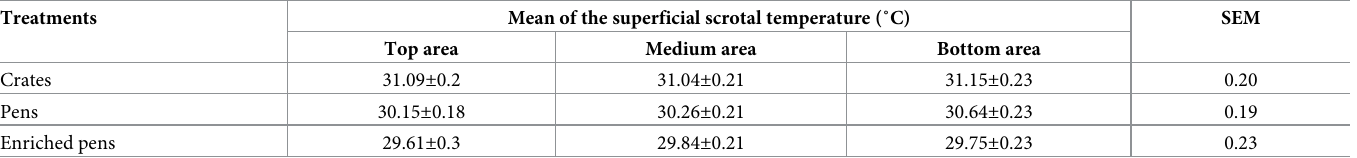
Table 3. Superficial Scrotal Mean Temperature (SSMT) and Standard Error Mean (SEM) of different areas of the scrotum from boars housed in three different con- ditions (Pens n = 9; crates n = 9, enriched pens n = 9).